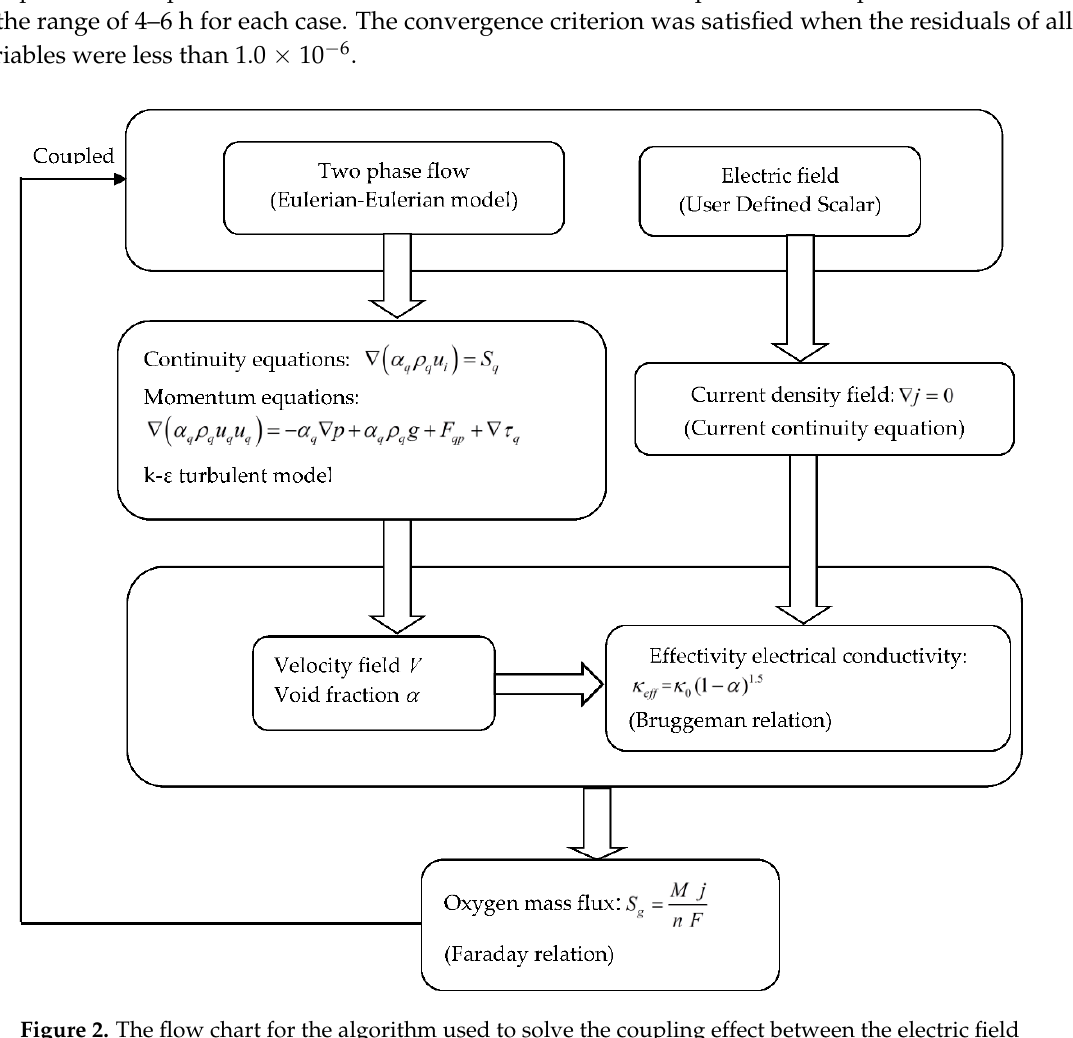
Figure 2. The flow chart for the algorithm used to solve the coupling effect between the electric field and velocity field.